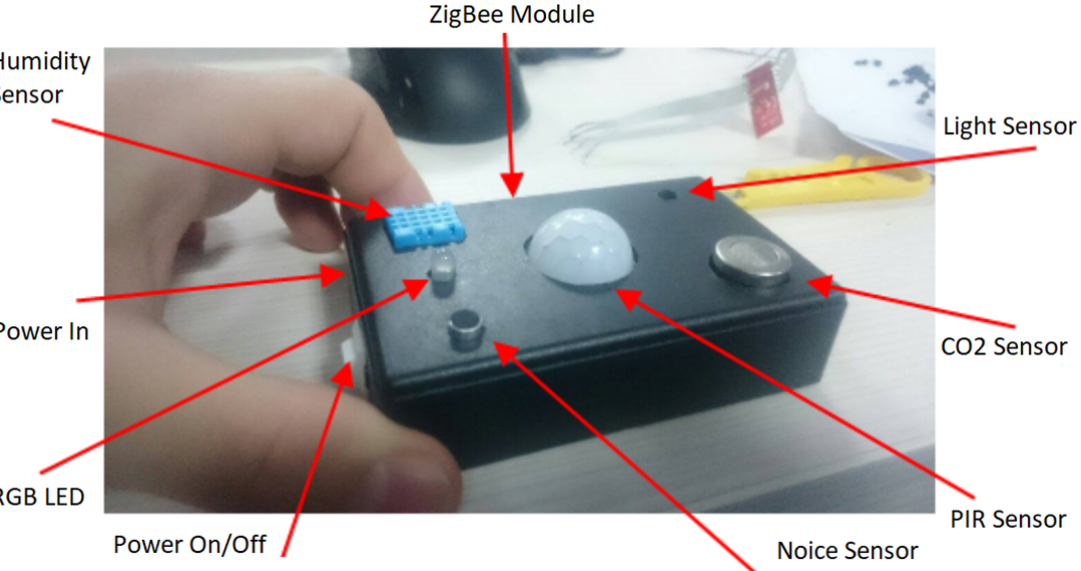
Figure 10. IoT device prototype for environmental data